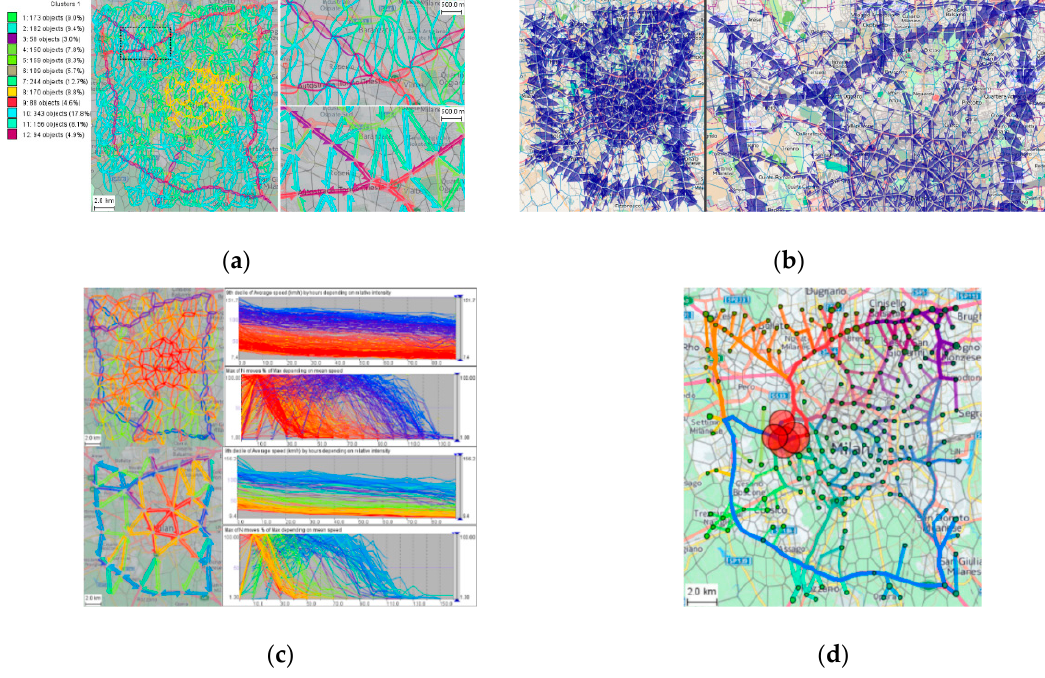
Figure 20. Related examples of abstract-space visualizations [55,56]: ( a – c ) related abstract